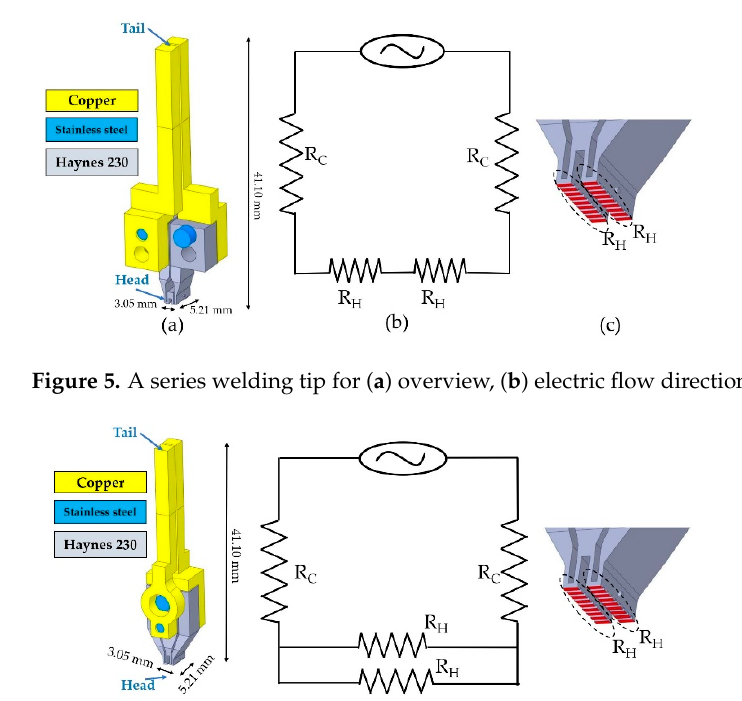
Figure 5. A series welding tip for ( a ) overview, ( b ) electric flow direction, and ( c ) enlarged head.